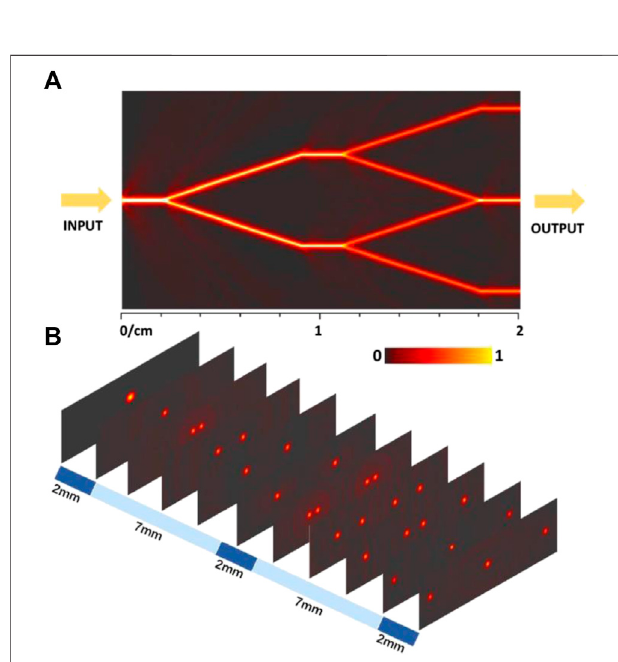
FIGURE 4 | (A) Top view of the simulated light intensity pro fi le after light propagating on the XY-plane at 632.8 nm at TM polarization. (B) Evolution process of light